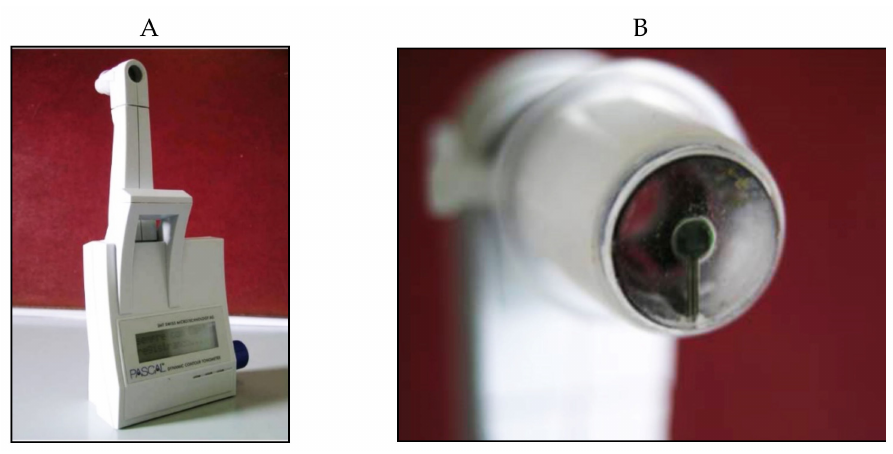
Figure 15. Dynamic Contour Pascal ( A ) with its sensor tip ( B